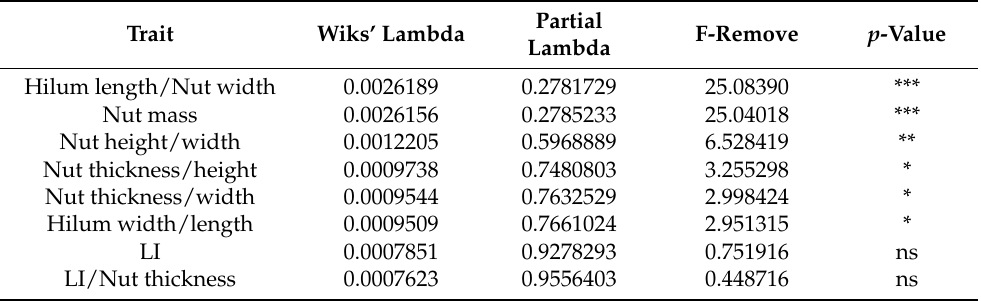
Table 6. Results of the stepwise discriminant analyses. p ( λ ), significance of Wilks’ λ : *** significant at p < 0.001, ** significant at 0.001 < p < 0.01, * significant at 0.01 < p < 0.05, ns non-significant values ( p >